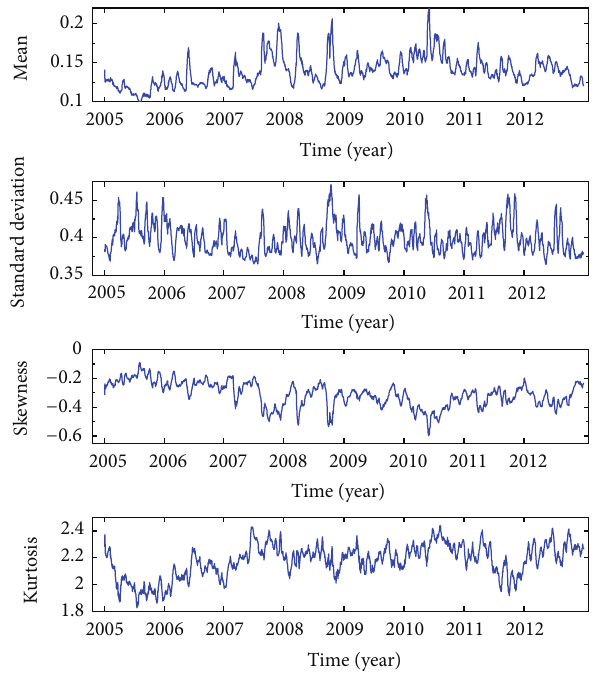
Figure 1: The mean, standard deviation, skewness, and kurtosis of cross-correlation coefficients of 42 currencies in the international FX market as functions of time.